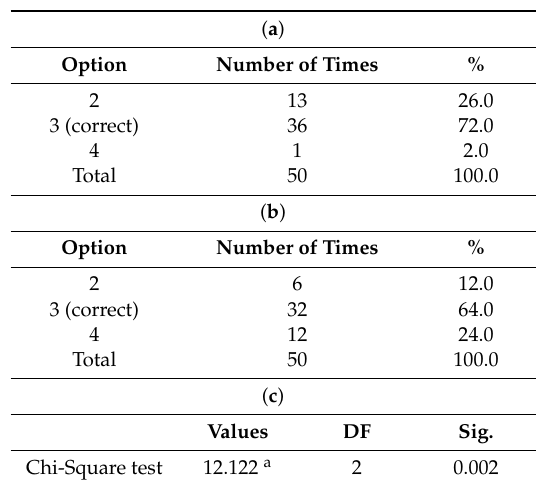
Table 1. ( a ) Estimation of referenced volume with the physical product; ( b ) estimation of referenced volume with the virtual prototype; ( c ) chi-square test for the referenced volume